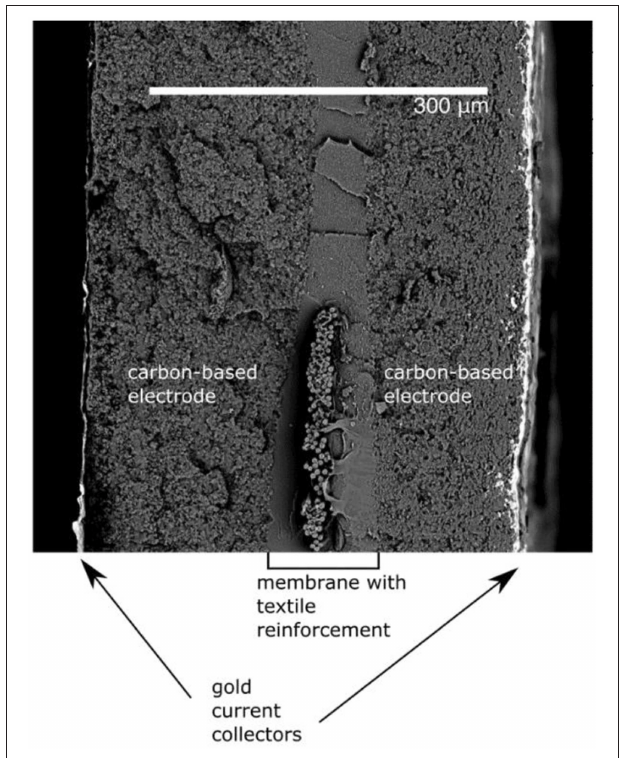
FIGURE 1 | Cryofractured cross-section of